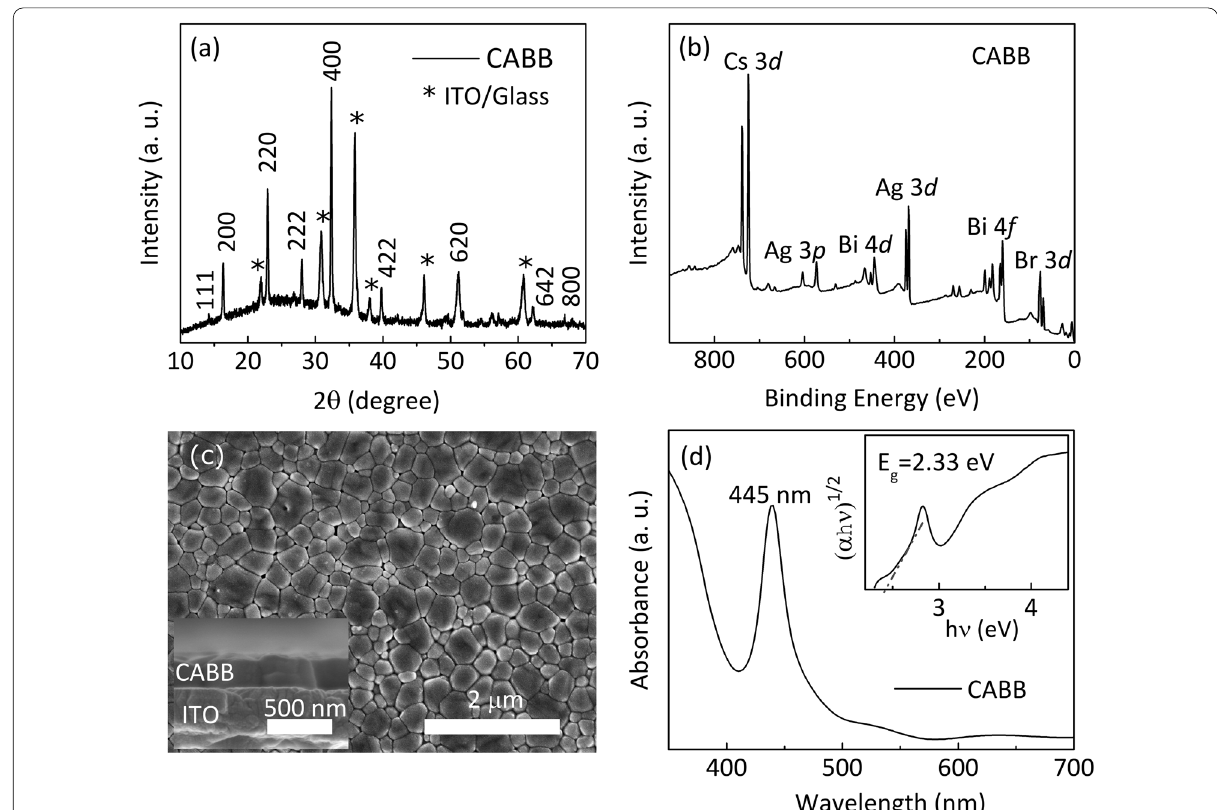
Fig. 2 a The longitudinal θ − 2 θ scans of the as-grown CABB film on the ITO/Glass substrate. ∗ represents peaks of the ITO/glass substrate. b XPS spectrum of CABB. c The top-view SEM image of films. The inset displays the cross-sectional SEM image of the CABB film. d Optical absorption spectrum of the CABB thin film measured at room